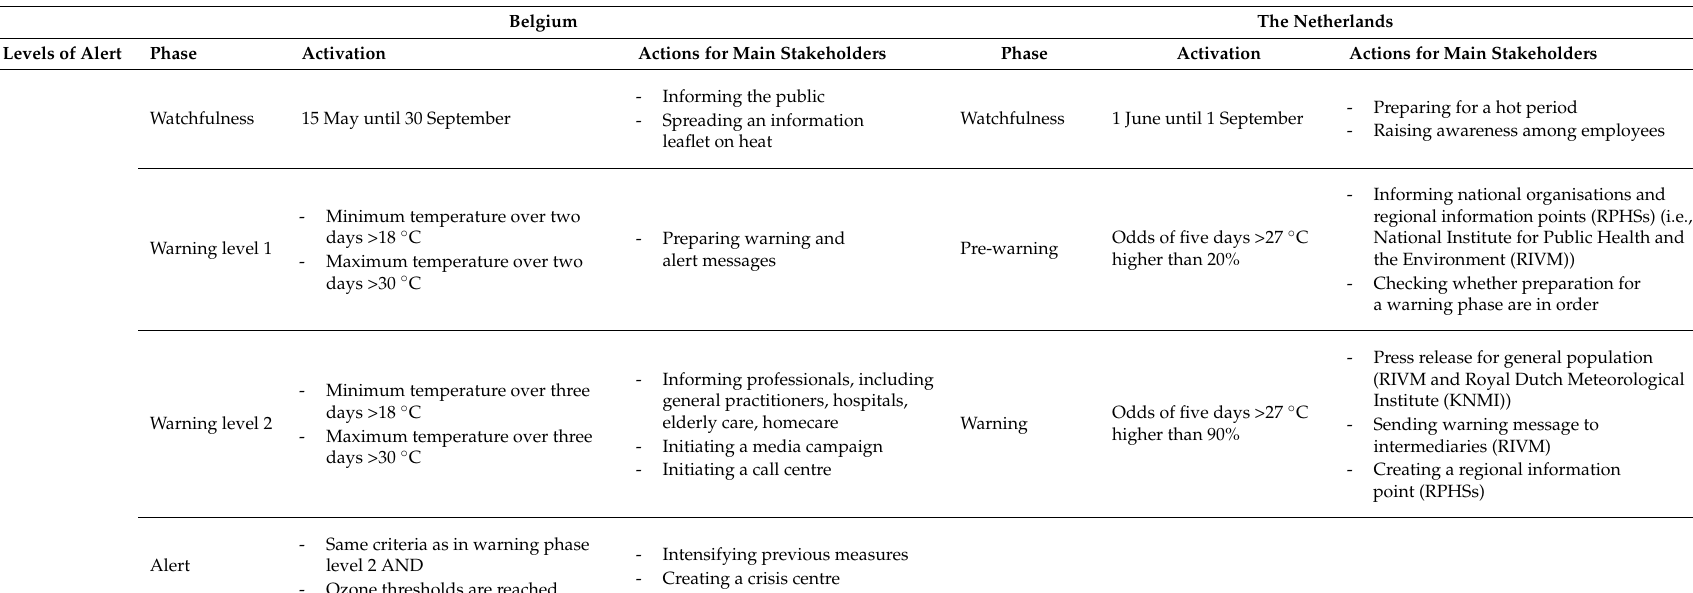
Table 1. Overview of the different levels of alert in the Belgian and Dutch National Heatwave